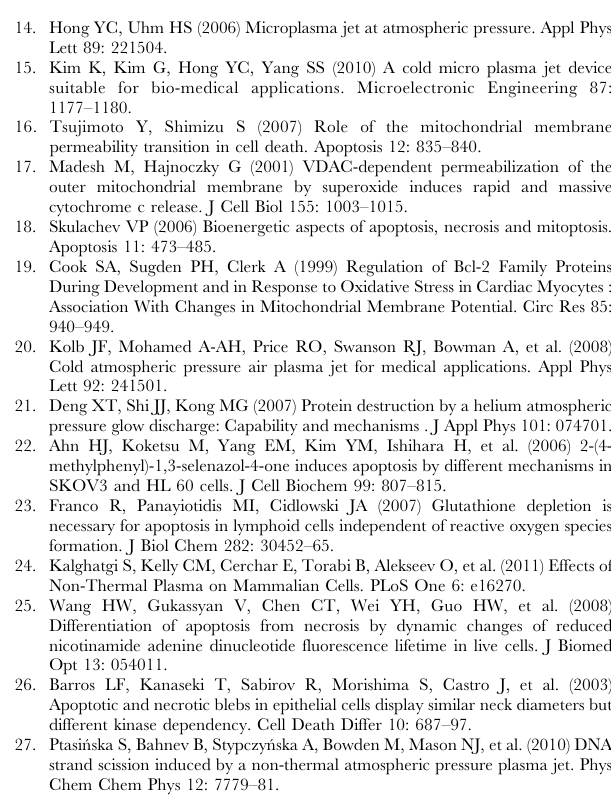
Figure S1 Apoptosis in HeLa cells, a human cervical carcinoma cell line, as analysed by flow cytometry. Cells were treated with N 2 or air plasma jets for 2, 5, or 8 min and then incubated further for 24 hr. After harvesting, cells were stained with anti-annexin V-FITC and PI and analysed by flow cytometry. (TIF) Figure S2 ROS generation was monitored using H 2 DCFDA. Cells were stained with H 2 DCFDA, within 1 hr after treatment with N 2 and air plasma jet for 5 min, then analysed by flow cytometry. The level of ROS generation increased in the N 2 (2.07 6 0.38) and air (2.63 6 0.04) plasma jet-treated cells, compared with the control (1.17 6 0.02), H 2 O 2 treated (1.73 6 0.12), N 2 gas treated (1.32 6 0.25), or air gas treated (1.31 6 0.31) cells. Data are shown as the mean 6 s.e.m, which is mean of green fluorescent intensity. (TIF) Figure S3 Mitochondrial transmembrane potential (MMP) was measured with JC-1 dye. Cells were treated with N 2 or air plasma jets for 5 min and then incubated for 12 h. After harvesting, the cells were stained with 2.5 m M JC-1 for 30 min, and analysed by flow cytometry. N 2 and air plasma jet- treatment reduced MMP (6.45 6 0.16 and 5.88 6 1.78, ratio of green fluorescence to red fluorescence intensity), in comparison to